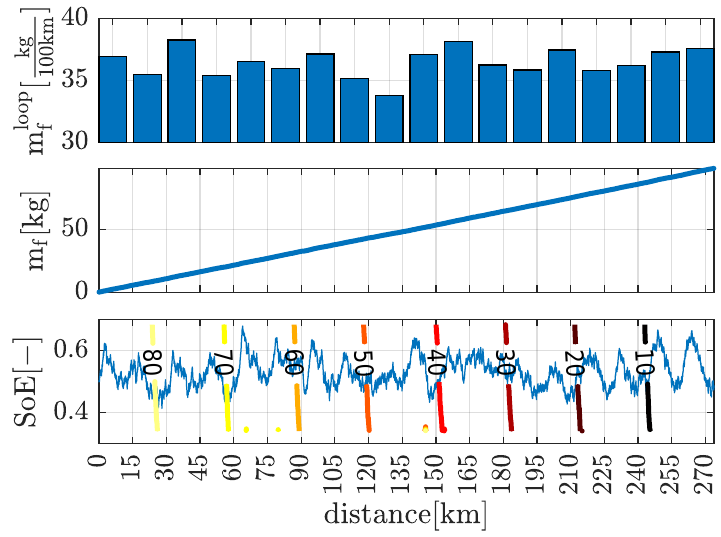
Figure 3. Evolution of the optimal fuel consumption ( top ) and battery SoE ( bottom ) of the vehicle as a function of the distance covered during the complete driving cycle. The colorscale in the bottom plot shows the cost-to-go ( J ∗ ( x , k ) ), in kg of fuel, depending on the vehicle position and energy in the battery assuming that the engine is on.